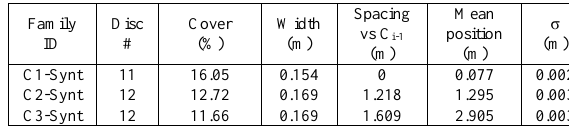
Table 6. Results from DiscontinuityLab: corridors information of F2-Synt family for the synthetic wall